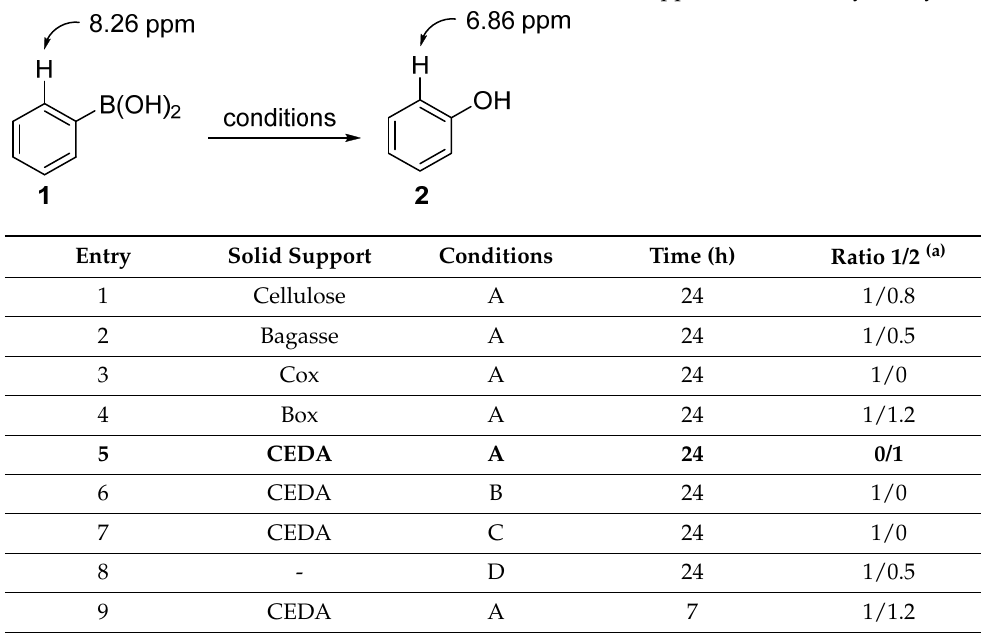
Table 1. Determination of most suitable solid support and catalytic system.